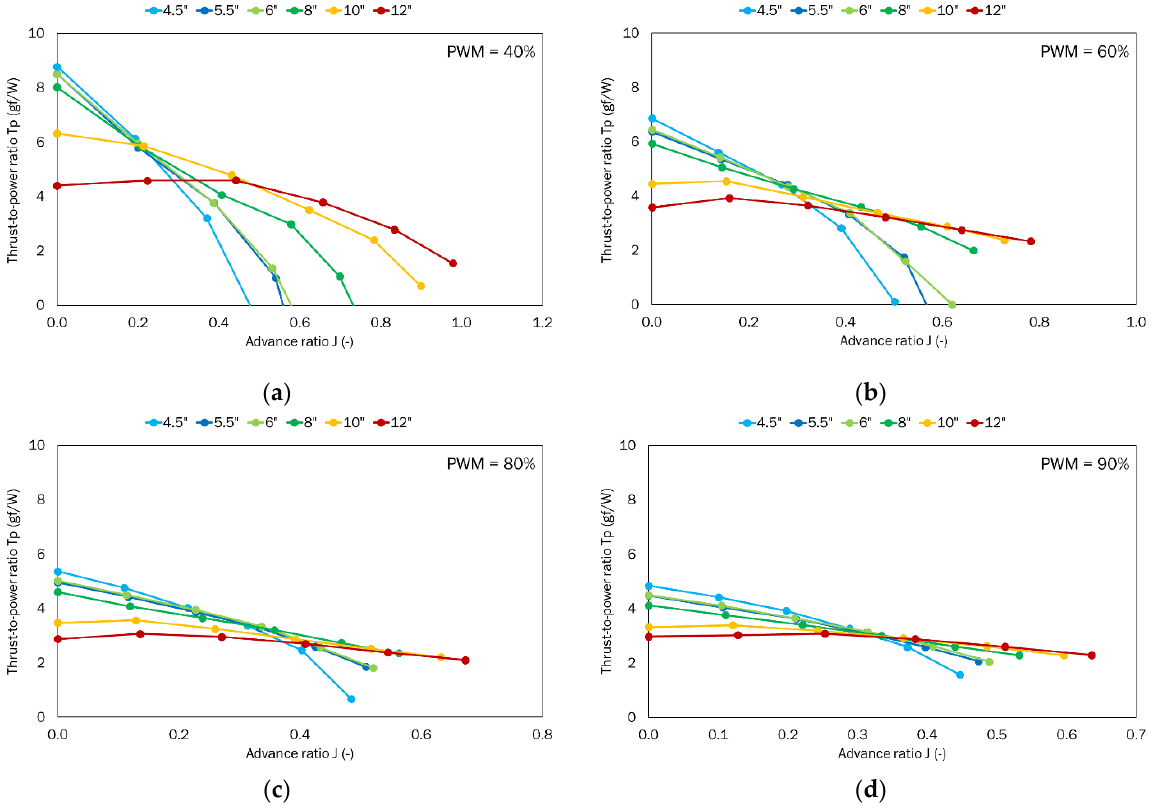
Figure 13. Thrust-to-power ratio as a function of the advance ratio for the tested set of propellers for the defined PWM values: ( a ) 40%; ( b ) 60%; ( c ) 80%; ( d )